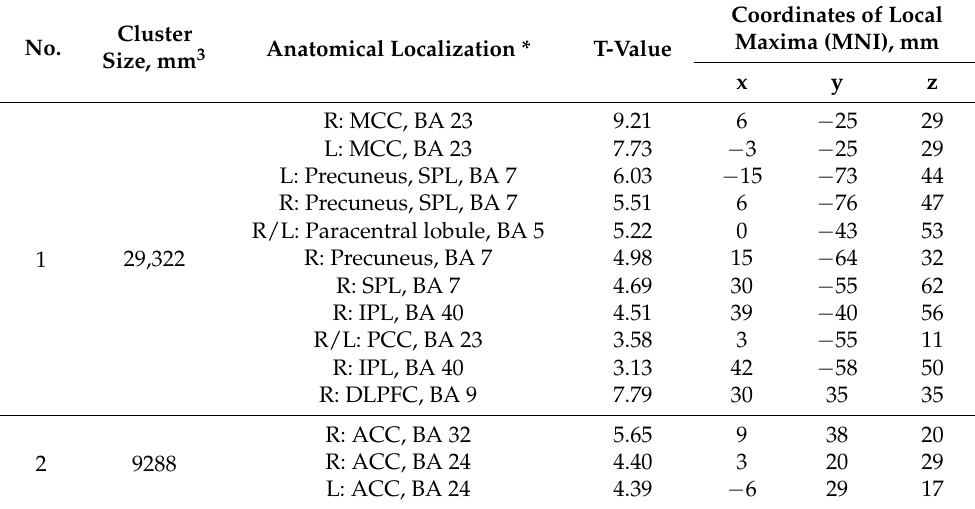
Table 3. Significant dependency between increased patients’ mean RT and decreased BOLD-signal in equiprobable Go and NoGo trials (“Go + NoGo” contrast). Cluster-level FWE-corrected threshold of